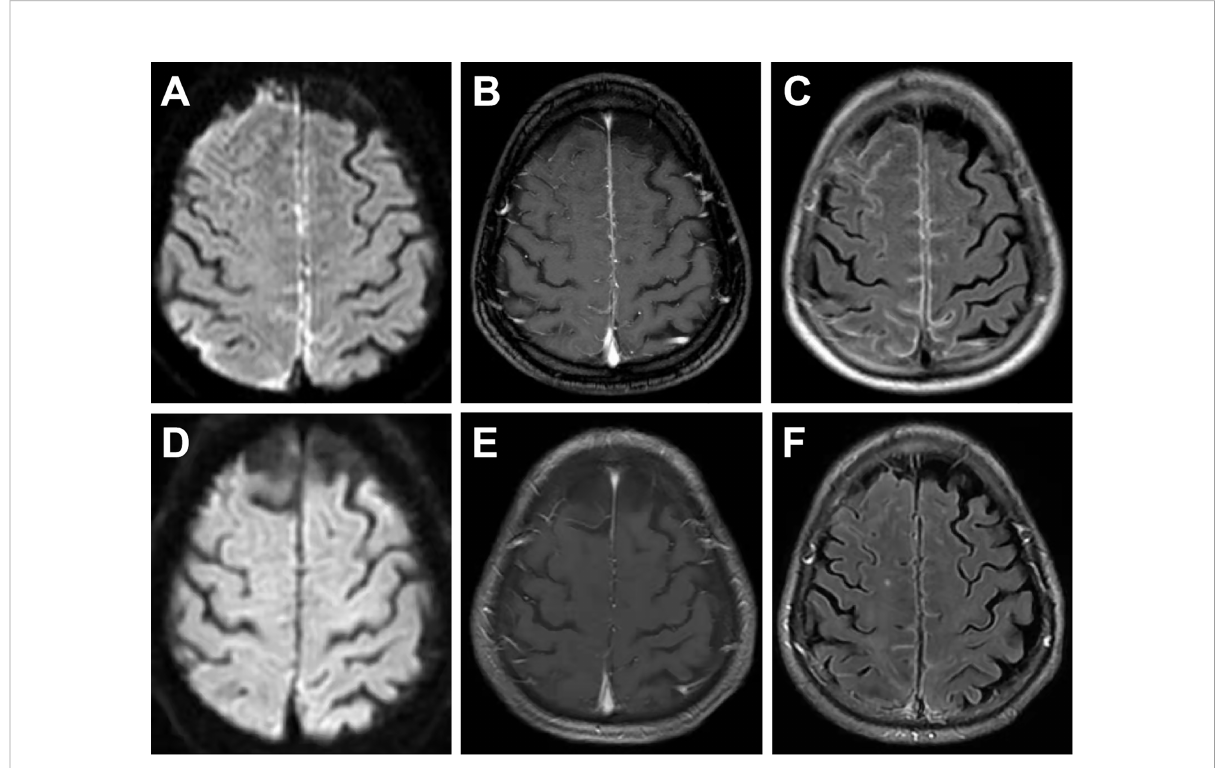
FIGURE 3 On the fi rst admission, brain MRI showed evident hyperintensity in the leptomeninges of the right frontal and parietal lobes and subtle hyperintensity in the left frontal and parietal lobes in DWI images (A) , contrast-enhanced T1-weighted sequences (B) , and contrast-enhanced FLAIR sequences (C) . MRI conducted at a 1-month follow-up showed subtle hyperintensity of the bilateral frontal and parietal lobes in DWI images (D) , contrast-enhanced T1-weighted sequences (E) , and contrast-enhanced FLAIR sequences (F)